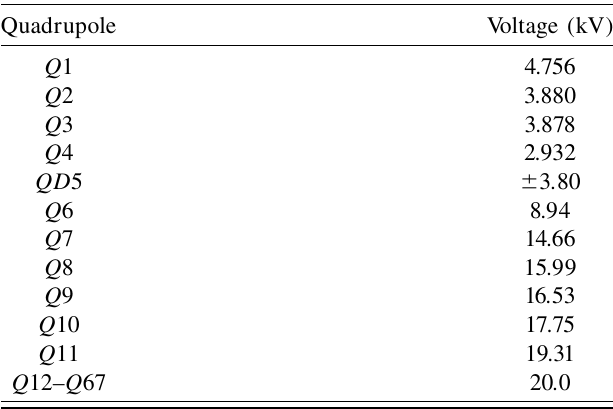
SCALED BEAM MERGING EXPERIMENT FOR HEAVY . . TABLE I. Typical quadrupole operating voltages. All the verse dimension for each beam. (Attached to the down- quadrupoles have four cylindrical electrodes per beam channel, stream slit of each pair is a Faraday cup which measures except for Q 4 and QD 5 . Q 4 has hyperbolic-shaped electrodes. the transmitted beam.) Each slit assembly is indepen- QD 5 , a combined dipole plus quadrupole, has the voltage distributed to the 71 individual tungsten electrodes via a resistive divider.